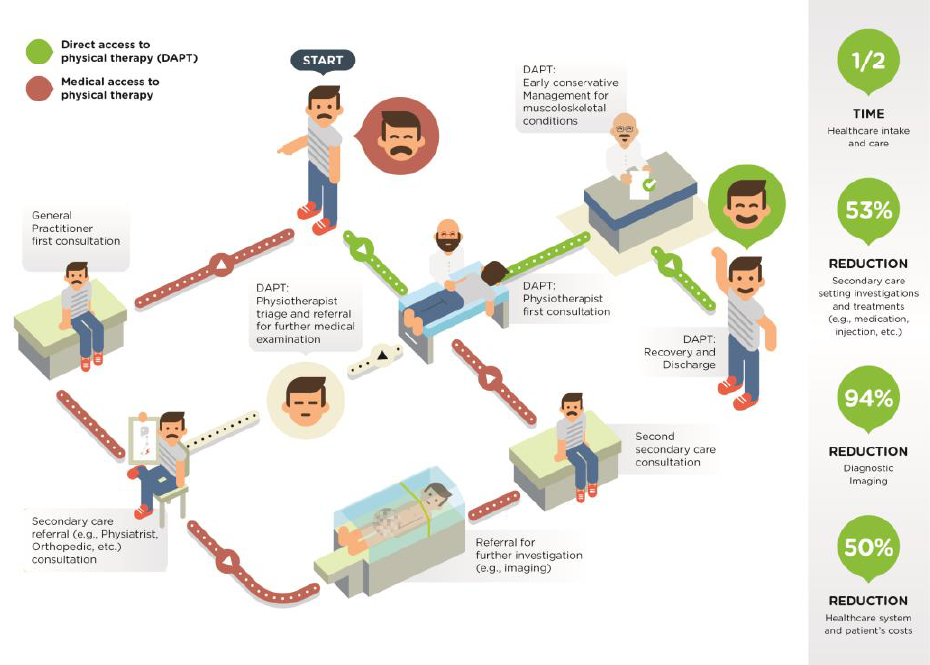
Figure 1. The main differences between access settings and the benefits offered by DAPT.